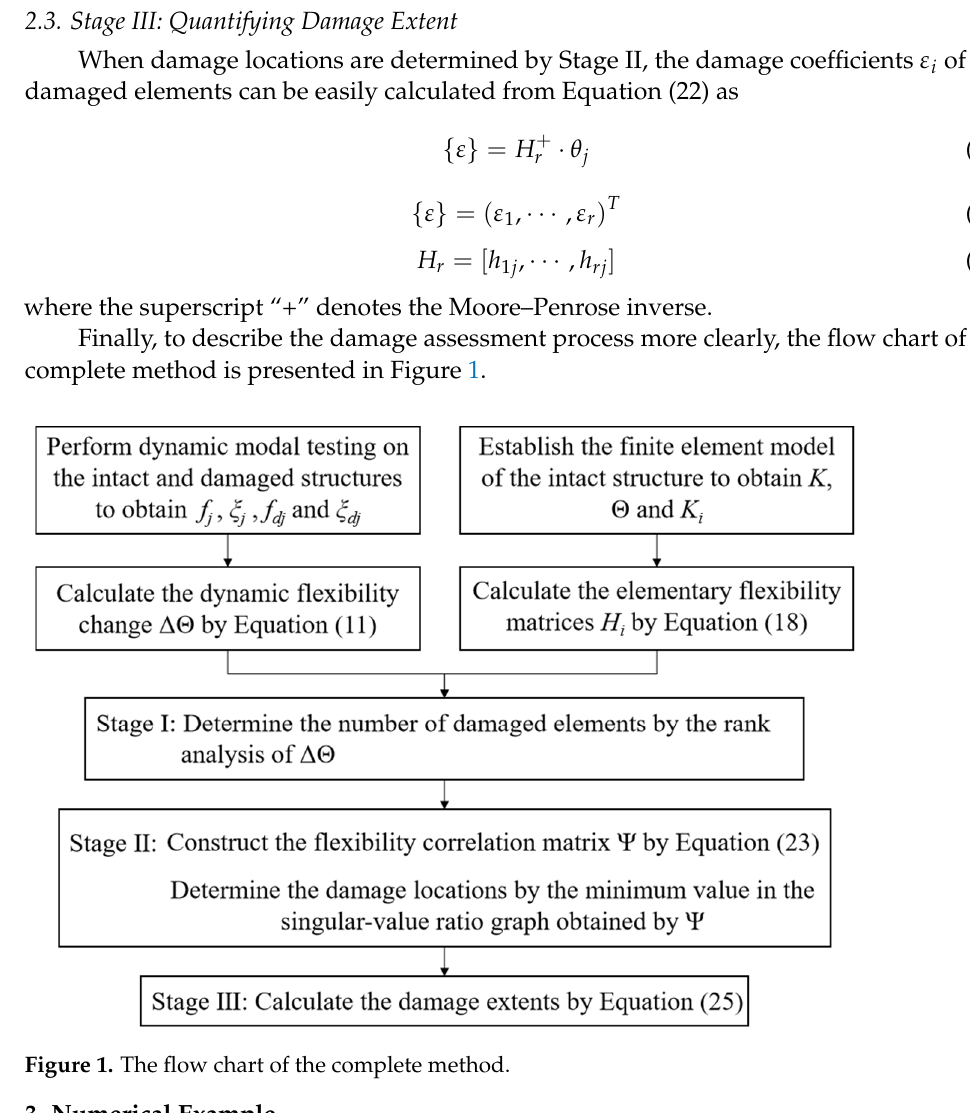
Figure 2. Numerical model of the 27-bar truss structure. Table 1. Natural frequencies without noise for the undamaged and damaged structures (unit: Hz). Frequency Number